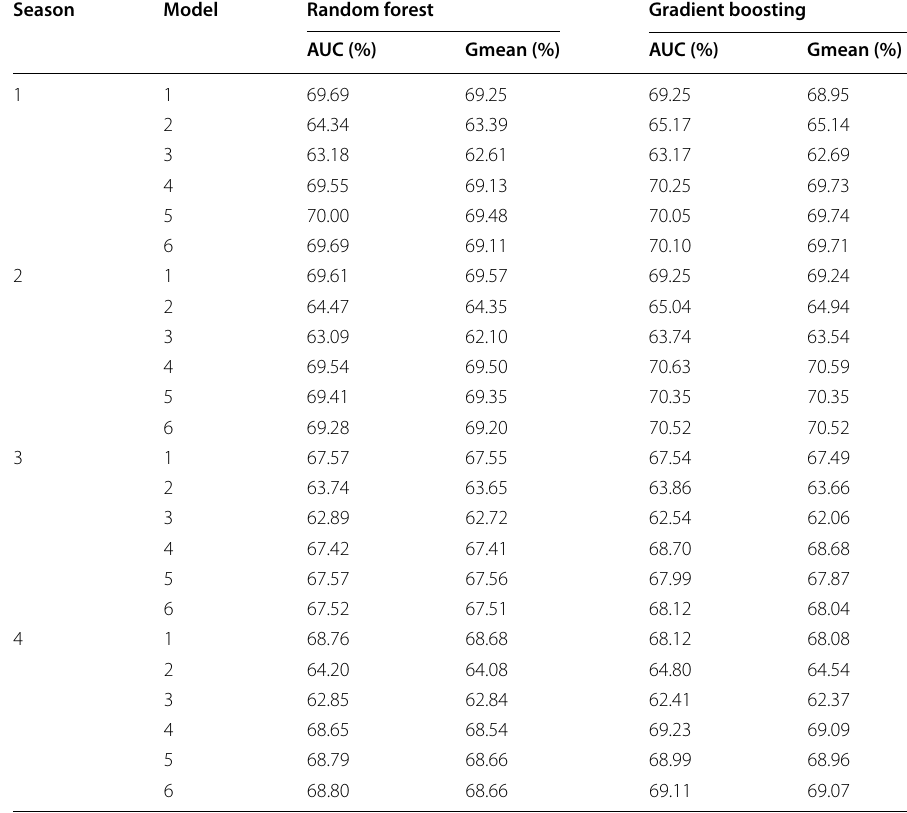
Table 6 Performance evaluation based on six different models Season